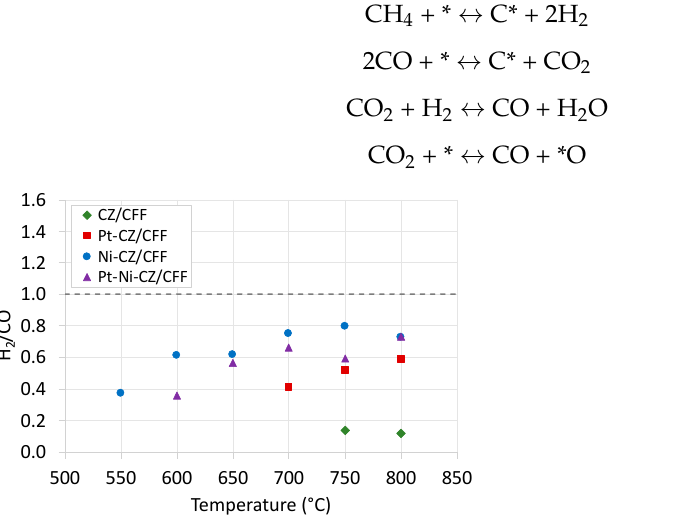
Figure 12. Contribution of DRM, reverse water-gas shift (RWGS) and CO 2 deoxidation (deOx) in CO 2 conversion during catalytic tests of DRM in isothermal conditions over Pt-CZ/CFF ( a ), Ni-CZ/CFF ( b ) and Pt-Ni-CZ/CFF ( c ). Reaction mix- ture: 4 vol. % CH 4 , 10 vol. % CO 2 , balanced with Ar. GHSV = 5000 h − 1 . TOS = 2 h. After DRM tests the catalysts were characterised with XRD, SEM/TEM and TGA (See the Supplementary Materials). The morphology of the catalysts changed to some extent after exposition to reaction conditions. First, the XRD for spent catalysts (Figure 13) showed the presence of the Ni phase, unlike in the case of fresh samples (Figure 1). The application of the Scherrer equation allowed to estimate the size of CeZrO 2 and Ni crys- tallites in (220) and (111) directions, respectively (Table 3). Depending on the sample, from 50% to 57% increase in the size of the CeZrO 2 crystallite after DRM was observed. Such an